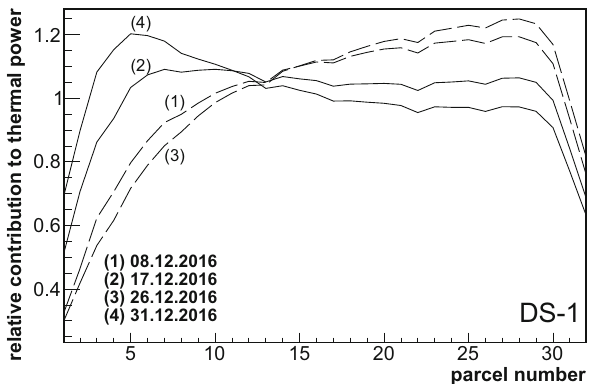
Fig. 17 Relative distribution of thermal power along the z-axis during DS-1 from core simulation data for selected days over the one month period. The dashed lines (1) and (3) correspond to the days, where the bottom core instrumentation in Fig. 15 gives the highest contribution different from (2) and